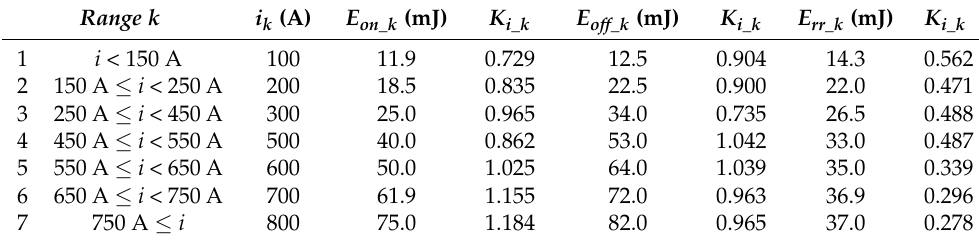
Table 2. Current exponents in different ranges used in Equation